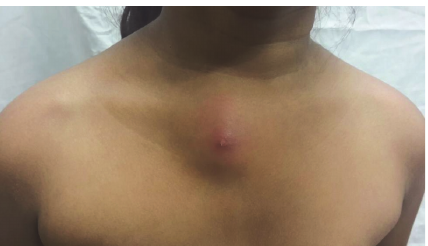
Figure 1: Clinical photograph showing swelling over the sternum.